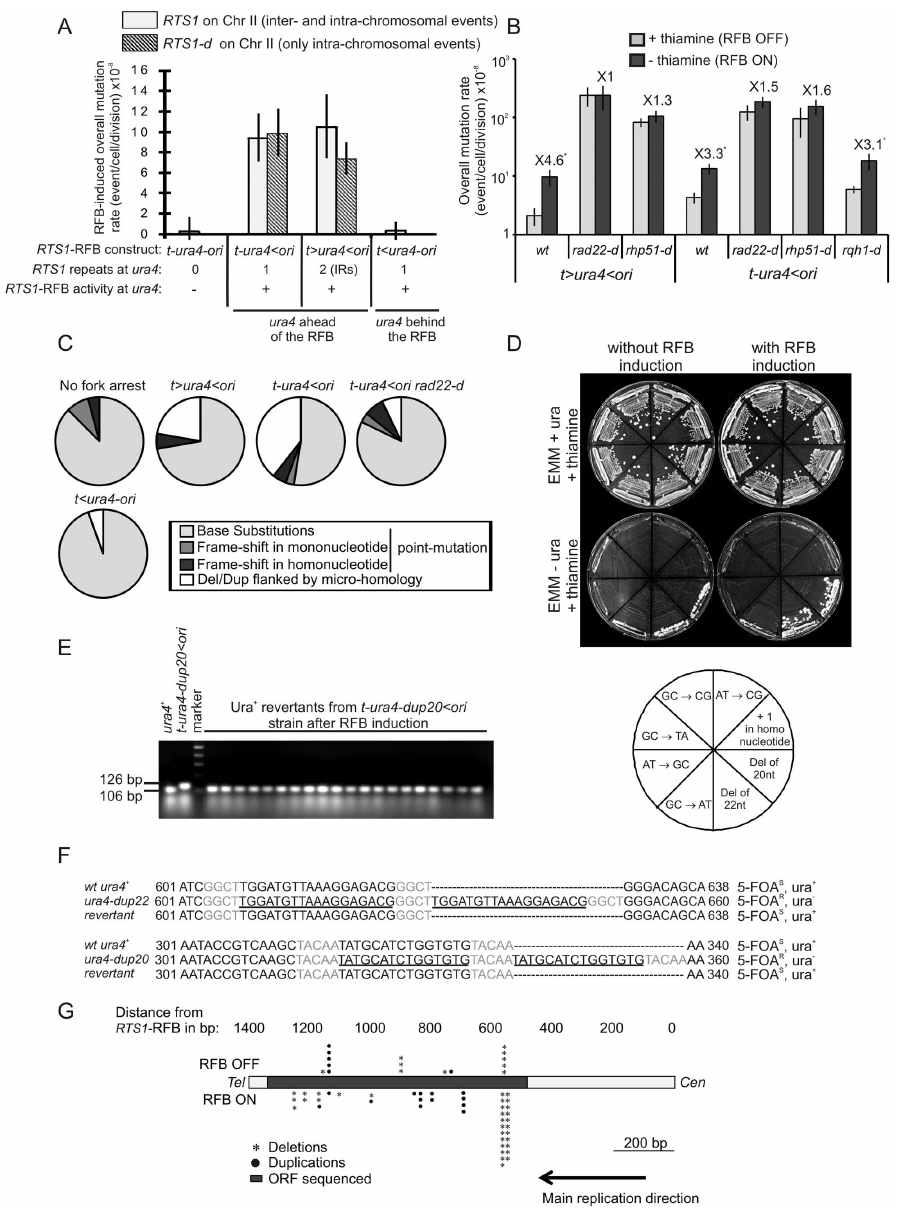
Figure 3. Fork-arrest induces mutations. A. Effect of intra- and inter-chromosomal recombination between RTS1 repeats on fork-arrest-induced mutation rates (base-substitutions, frame-shifts and small insertions or deletions between short tandem repeats). RTS1 -RFB activity and ura4 location with respect to the RFB are given for each construct. The % of mutation events, as determined by the PCR assay and sequencing, was used to balance the rate of ura4 loss. Then, the RFB-induced mutation rate was calculated by subtracting the rate obtained in the presence of thiamine (Rtf1 being repressed) from the rate obtained in the absence of thiamine (Rtf1 being expressed). The values reported are means of at least 3 independent median rates. Error bars correspond to SE. (Refer to Figure S2 for corresponding rates of mutation when Rtf1 is expressed or not). B. Rate of mutation for indicated strains; ON and OFF refers to the RTS1 -RFB being active or not, respectively. The % of mutation events, as determined by the PCR assay and sequencing, was used to balance the rate of ura4 loss. The values reported are means of at least 3 independent median rates. Error bars correspond to SE. Statistically significant fold differences in mutation rates between the ‘‘OFF’’ and ‘‘ON’’ conditions are indicated with an *. C. Spectra of mutation events in indicated strains upon RFB induction (refer to Table 2 for exact numbers and to Figure S3 for mapping of deletions/duplications and their features). D. Strains harbouring the ura4 alleles with a single base-substitution or frame-shift or duplication of 20 or 22 nt, together with the RTS1 -RFB in the t-ura4 , ori configuration were streaked onto the indicated media after cell growth with (RFB ‘‘OFF’’) or without (RFB ‘‘ON’’) thiamine. The bottom diagram indicates strain positions and the mutation events required to obtain Ura + revertants. E. PCR analysis of Ura + revertants isolated from the t-ura4-dup20 , ori strain (duplication of 20 nt in ura4 ) after RFB induction. With the primers used, a 106 bp fragment is amplified from the ura4 + strain and a 126 bp fragment is amplified from the t-ura4-dup20 , ori strain. F. Sequence alignments of ura4-dup22 , ura4-dup20 , ura4 + alleles and corresponding Ura + revertants. Micro-homologies are indicated in grey and duplicated sequences are underlined in black. The phenotype of each allele is indicated on the figure. G. Map of deletion and duplication events within the ura4 ORF.